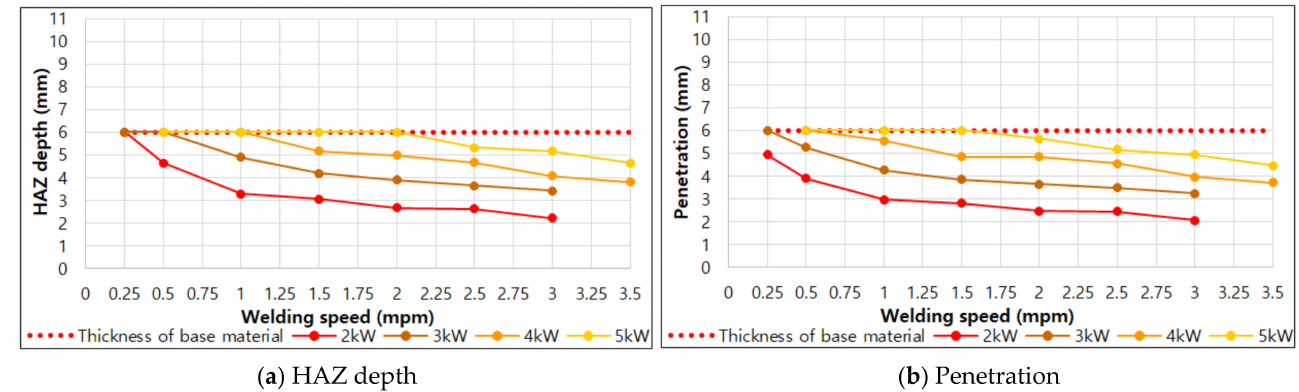
Figure 7. HAZ depth and penetration according to welding speed under each laser output condition.